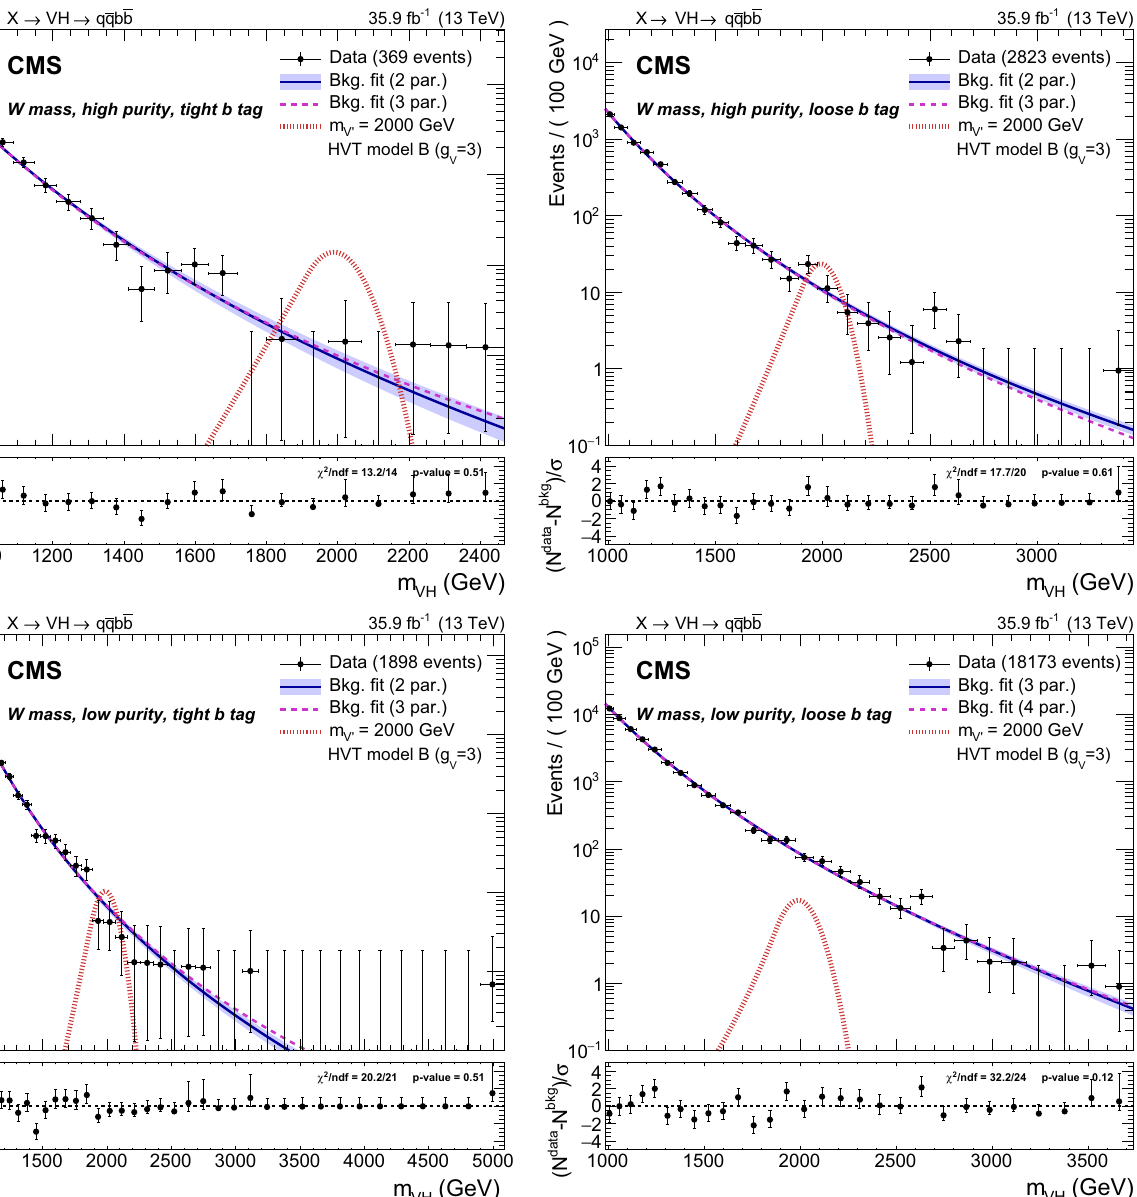
( N data − N bkg )/σ , where σ is the Poisson uncertainty in data. The hor- izontal bars on the data points indicate the bin width and the vertical bars represent the normalized Poisson errors, and are shown also for bins with zero entries up to the highest m VH event. The expected con- tribution of a resonance with m X = 2000 GeV, simulated in the context of the HVT model B, is shown as a dot-dashed red